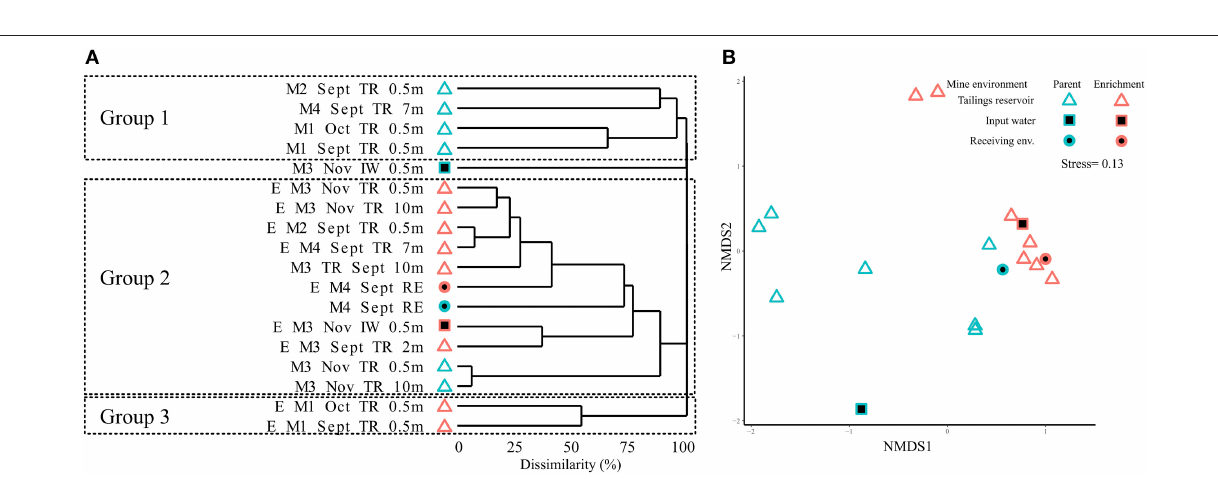
Frontiers in Microbiology |